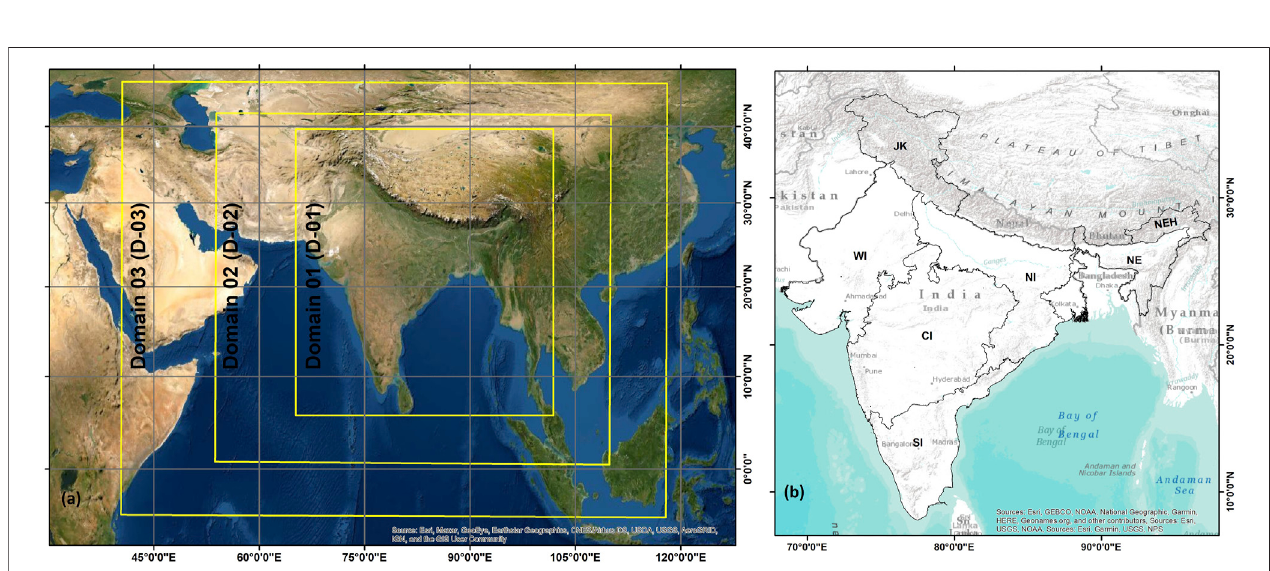
FIGURE 2 | (A) Model domain, D-01 (8,560 grids with 81 km grid spacing); D-02 (44,037 grids with 27 km grid spacing); D-03 (210,202 grids with 9 km grid spacing) — used in WRF simulation and (B) Indian Meteorological Department (IMD)-based classi fi ed climatological regions.